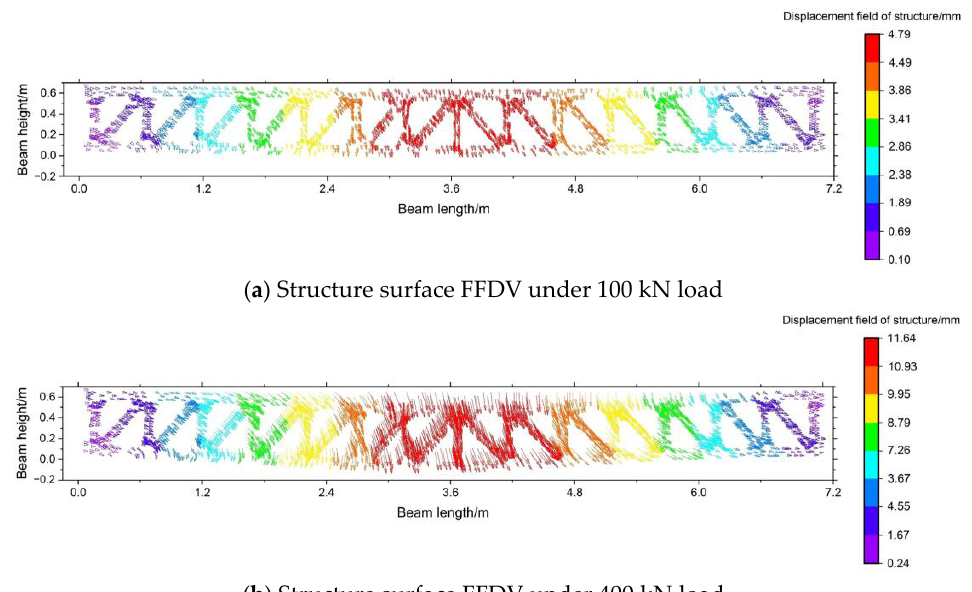
Figure 20. Structure surface FFDV under D03 condition.